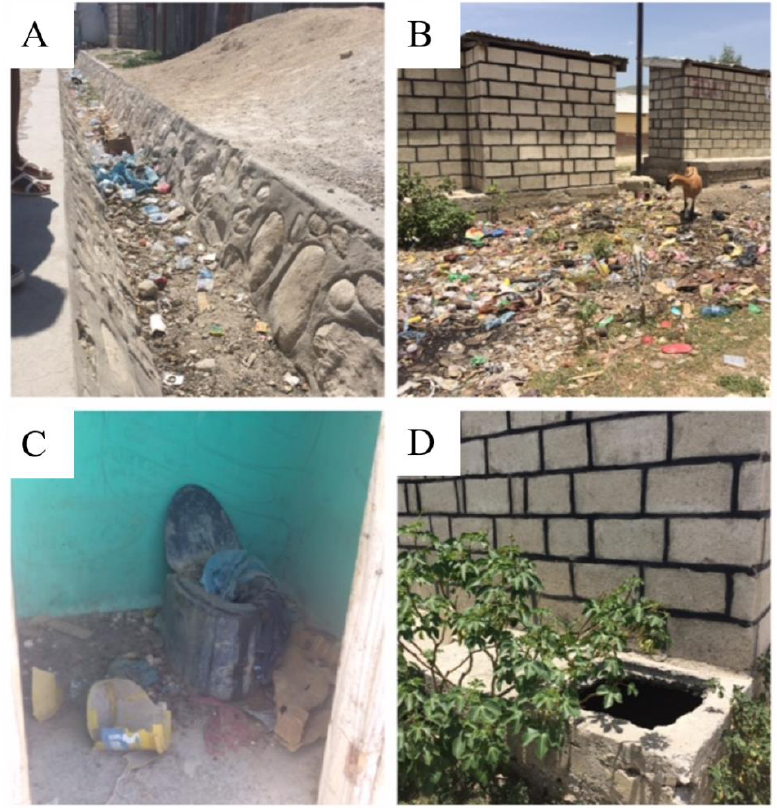
Figure 3. Illustration of environmental conditions in public areas. ( A ) Open drainage canal used for trash disposal; ( B ) Goat roaming in a trash pile behind a latrine; ( C ) Public latrine in poor condition; ( D ) Latrine pit without a cover.